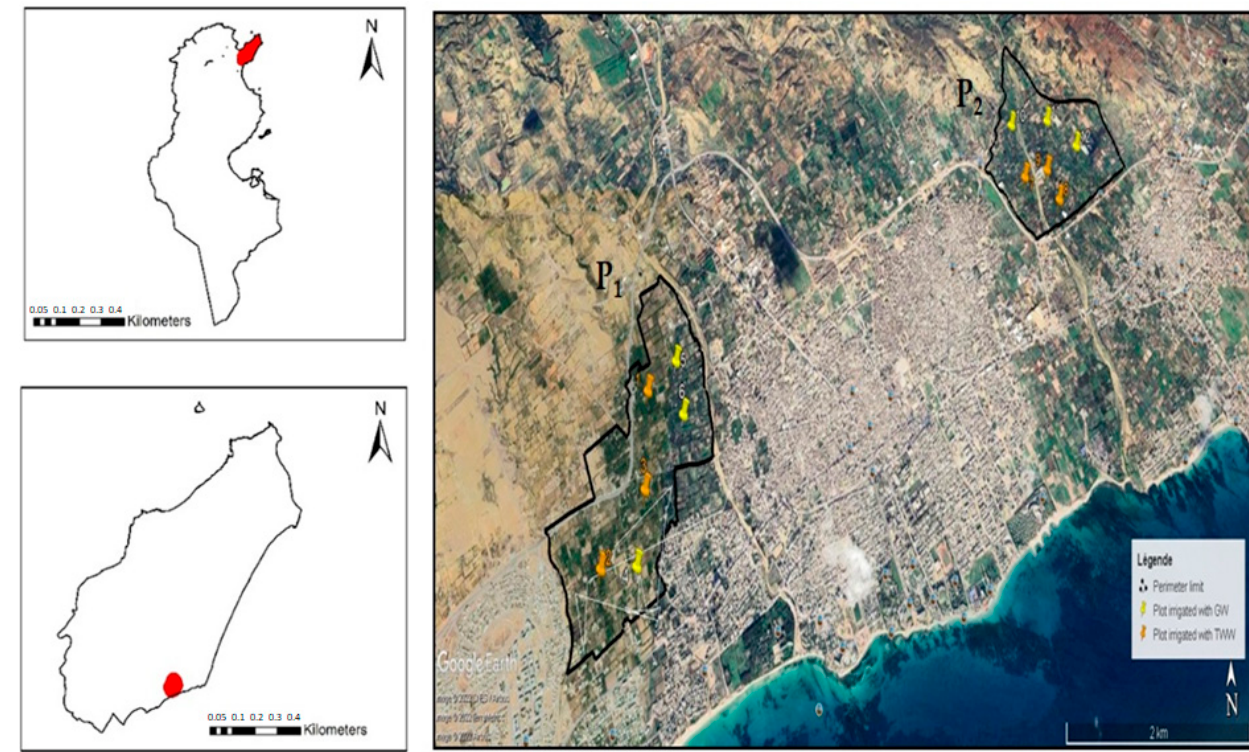
Figure 1. Map of the study areas.